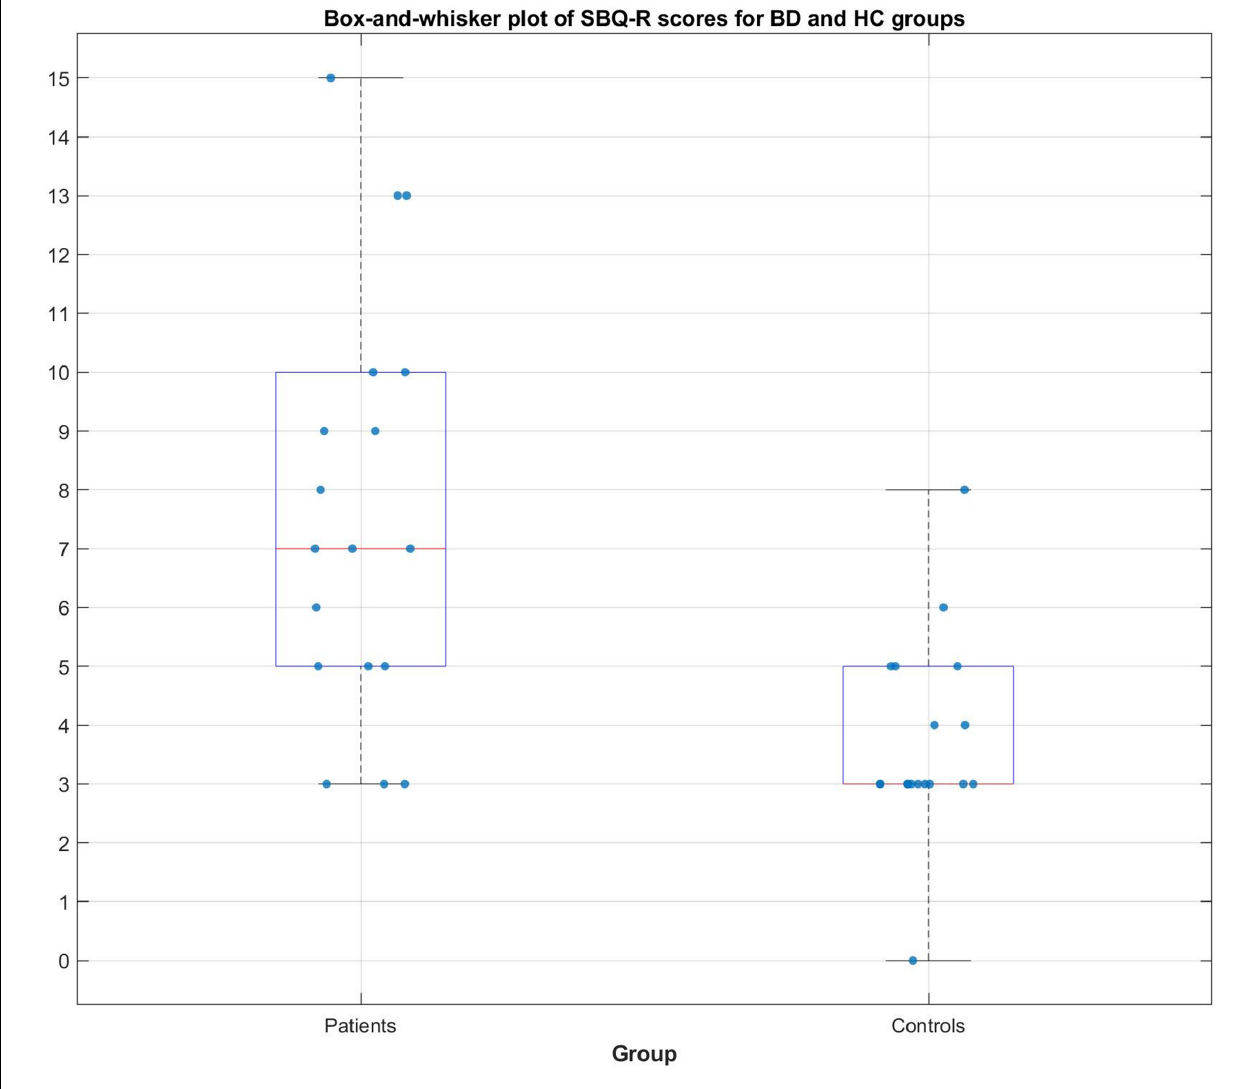
FIGURE 1 | Distribution of SBQ-R score for BD and HC